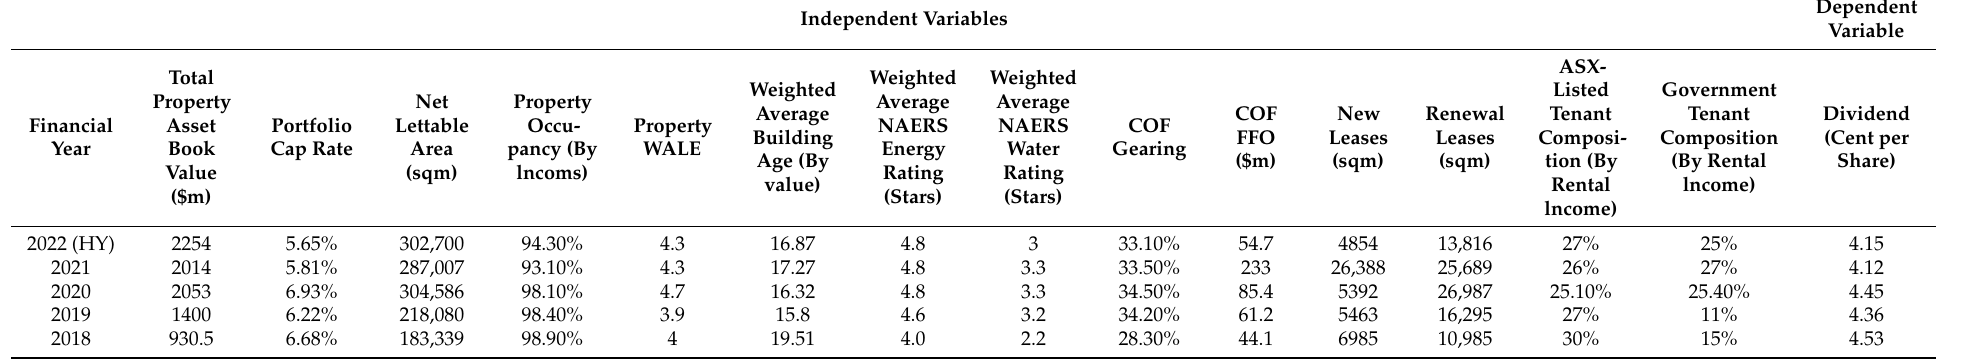
Table 4. Variables